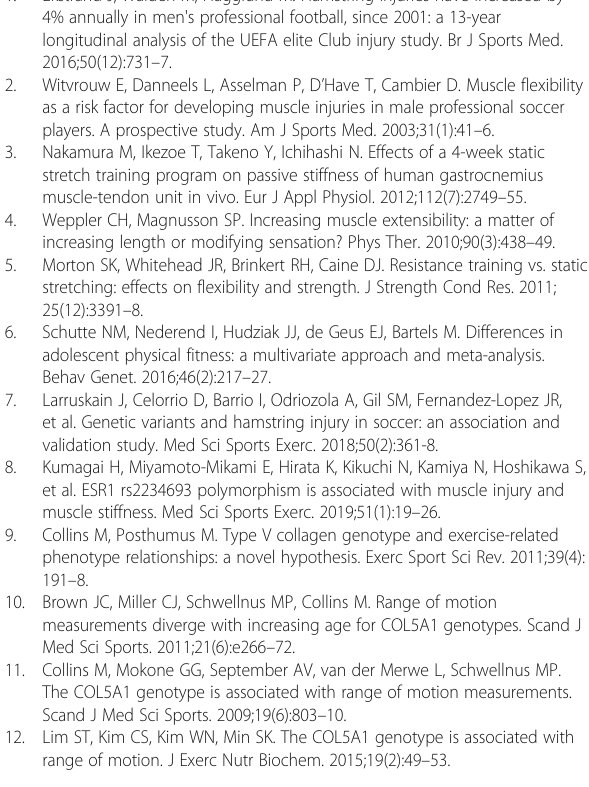
Additional file 1: Table S1. Participant characteristics by COL5A1 genotype in men and women of Study 1. Abbreviations ANCOVA: Analysis of covariance; BF: Biceps femoris long head; CI: Confidence intervals; COL5A1: Collagen type V α 1 chain; OR: Odds ratios; PSLR: Passive straight-leg-raise; ROM: Range of motion; SM: Semimembranosus; SR: Sit-and- reach; ST: Semitendinosus; UTR: Untranslated